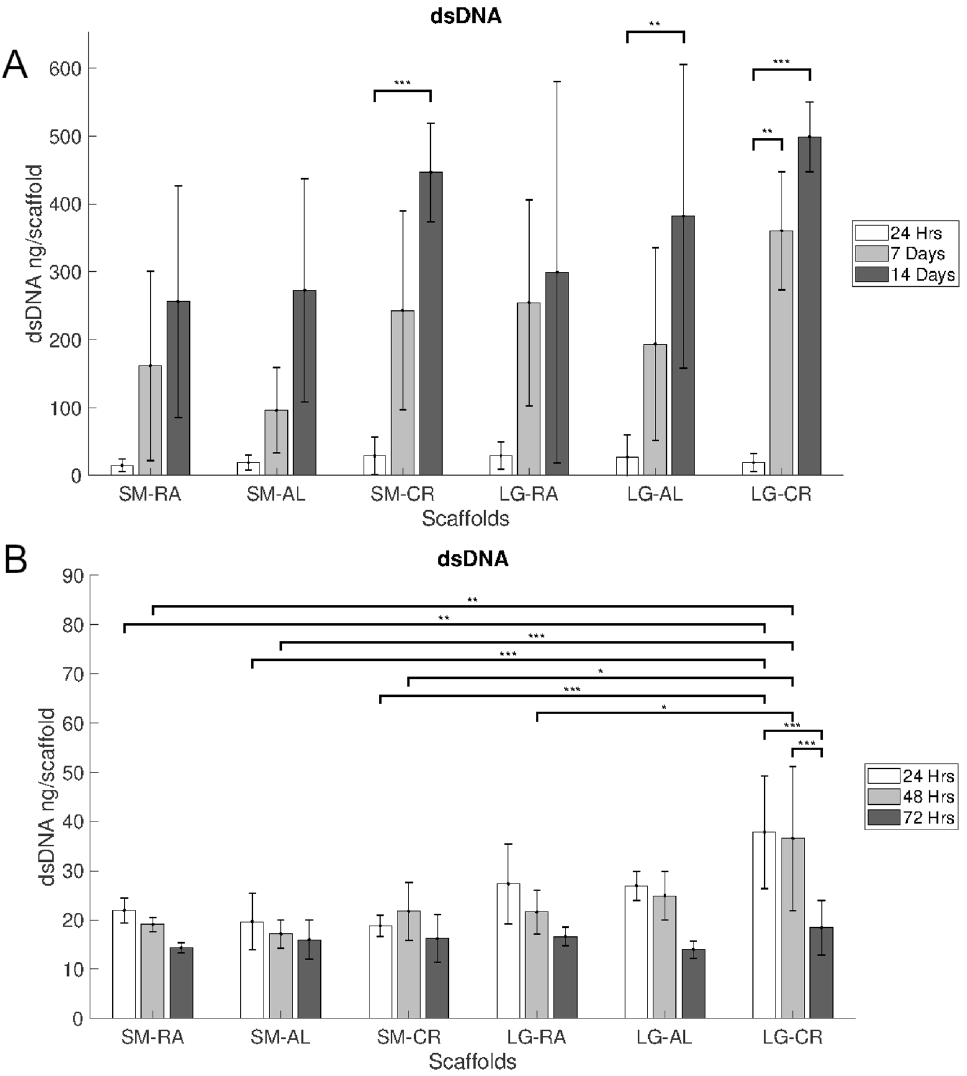
Figure 4. Picogreen dsDNA measurements for ( A ) hepg2 over 14 days and ( B ) MPHs over 3 days. N = 5, Error bars = SD and *p < 0.05, **p < 0.01 and ***p <